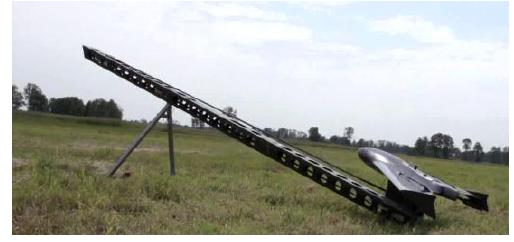
Figure 1. Trimble UX-5 – before flight